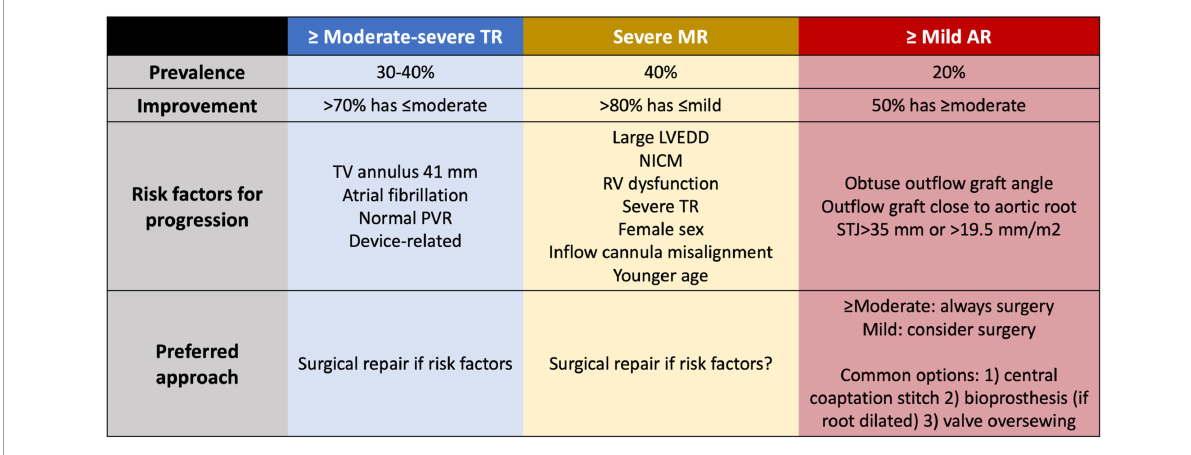
much lower (160). However, an isolated annuloplasty band for severe TR related to a pacing lead will predictably